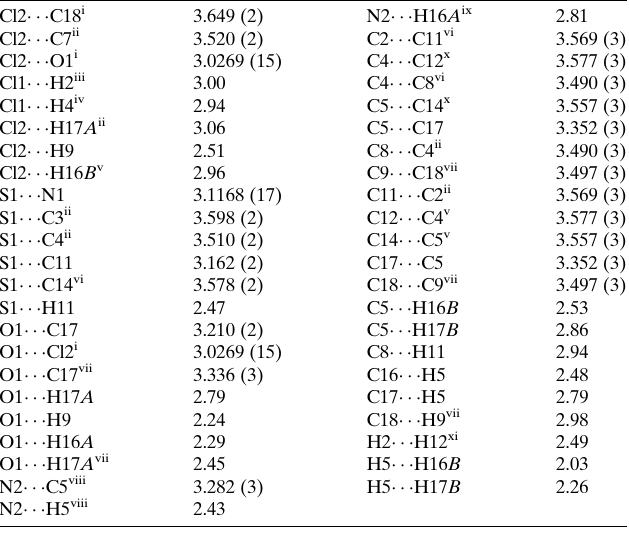
Table 2 Selected interatomic distances (A˚ ).